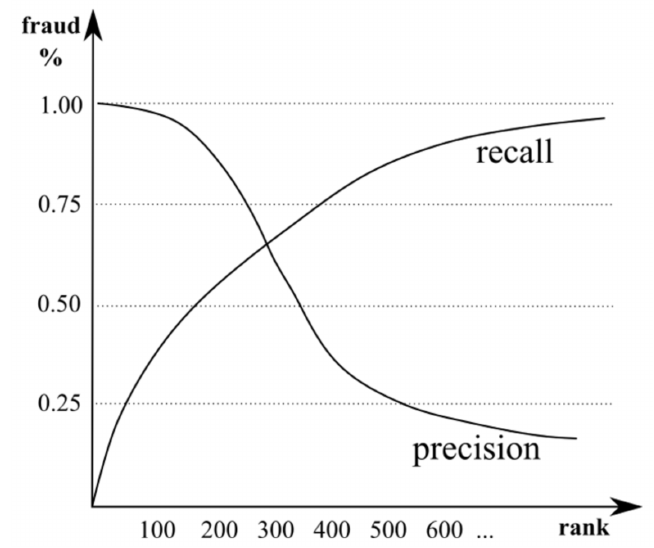
Figure 5. Precision and recall charts with characteristic curves.